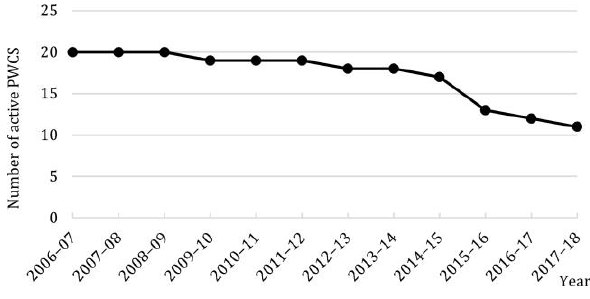
Fig. 4. Number of active PWCS (Tarakeswar zone) (Source: Handloom Development Office, Chinsurah, 2018)